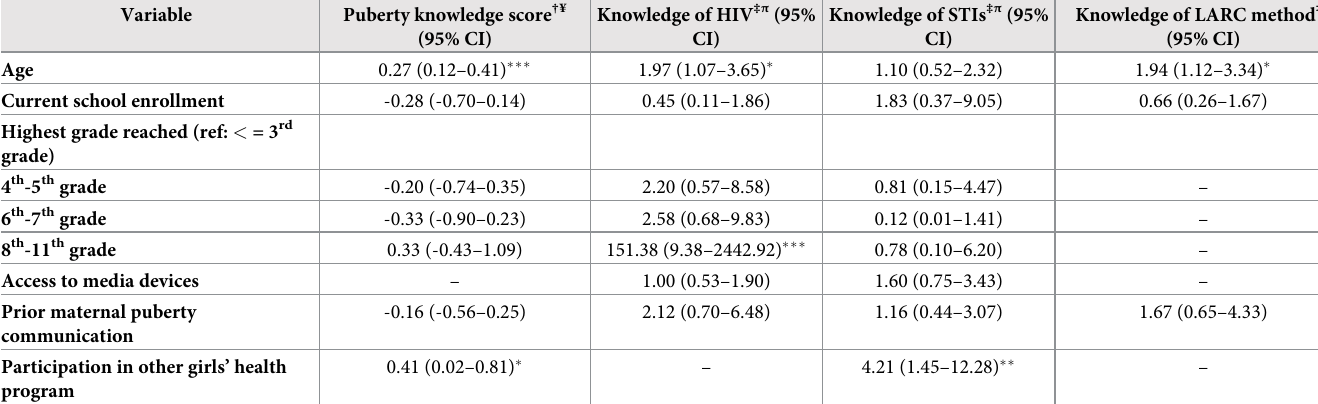
Table 6. Multivariate analysis of knowledge outcomes of interest.